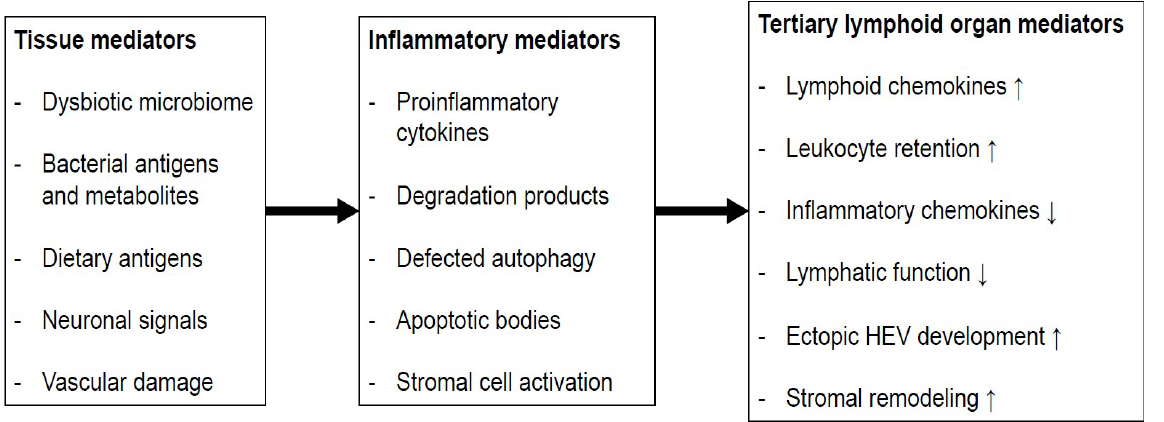
Figure 3. The putative process of intestinal TLO formation: Tissue factors present in the colon may result in the release of inflammatory mediators that enable the processes that promote the development of TLOs. HEV: high endothelial venule; ↑ : increase; ↓ : decrease. Recent discoveries have highlighted the role of ILCs in intestinal mucosal homeostasis and IBD [57,59–62]. Anomalies in the ILC population balance disrupt intestinal homeostasis, resulting in gut inflammation. The balance of ILC1s and ILC3s is closely linked to IBD and gut inflammation